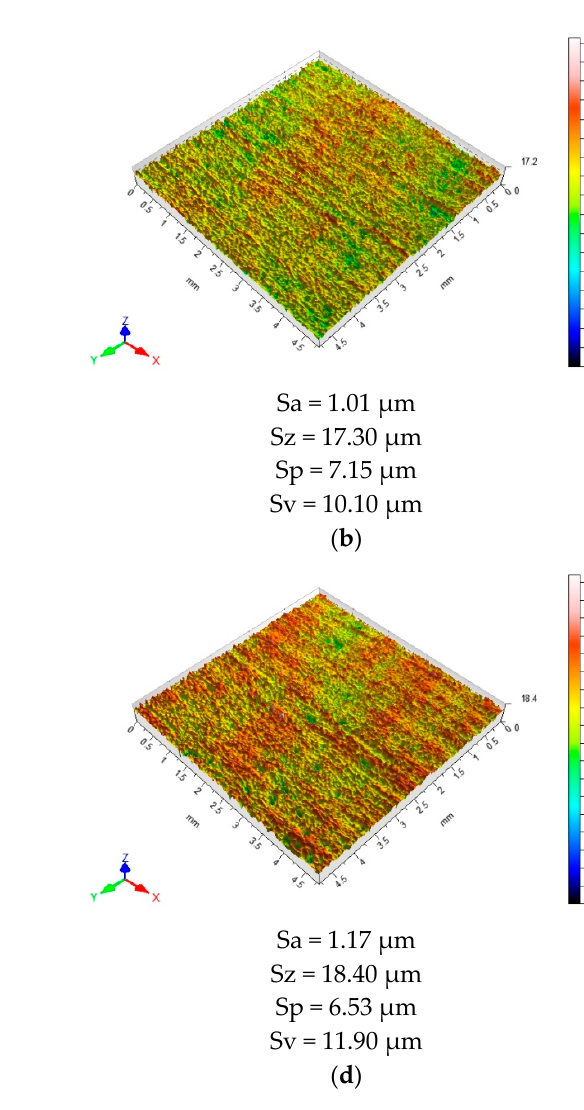
Figure 10. Surface topography after milling: ( a ) aluminum alloy in Al/CFRP configuration using a coated tool, ( b ) CFRP composite in Al/CFRP configuration using a coated tool, ( c ) aluminum alloy in CFRP/Al configuration using a coated tool, and ( d ) CFRP composite in CFRP/Al composite configuration using a coated